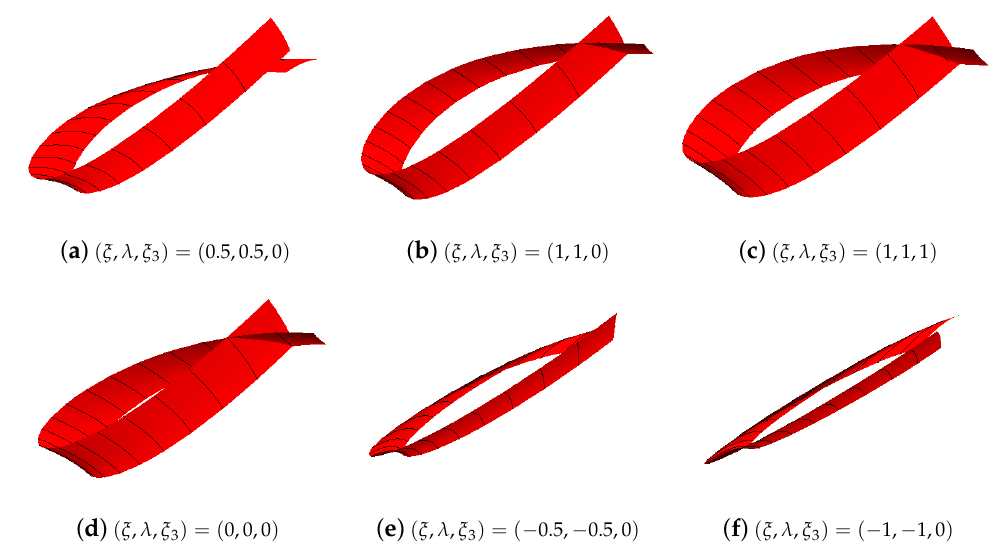
Figure 8. Graphical representation of Developable GHT-Bézier canal surfaces with different shape